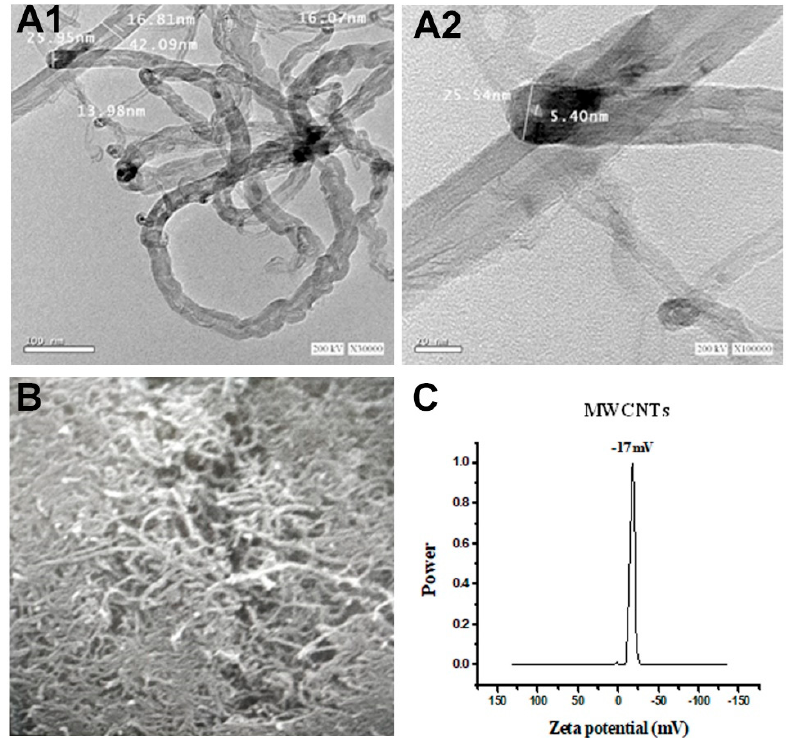
Figure 1. Characterization of pristine MWCNTs by transmission electron microscope ( A1 , A2 ), scan- ning electron microscope ( B ), and zeta potential ( C ).